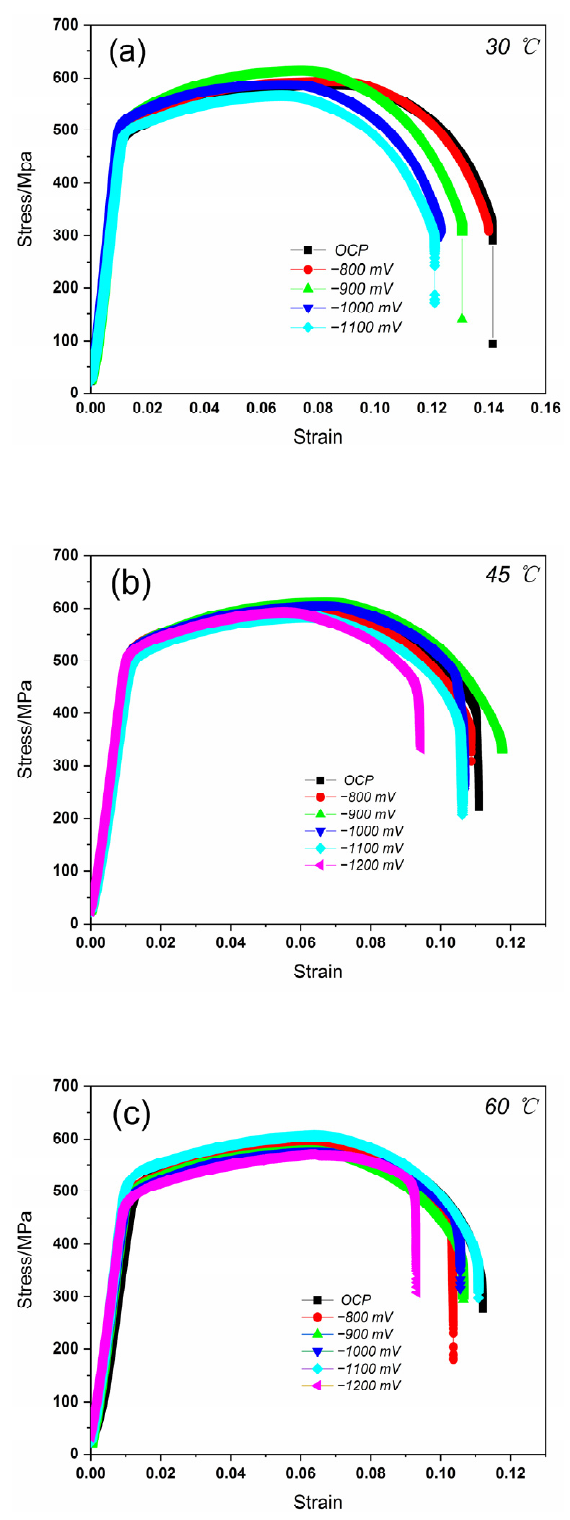
Figure 7. The SSRT curves for X80 steel at different CP potentials in soil medium at ( a ) 30 ◦ C, ( b ) 45 ◦ C, and ( c ) 60 ◦